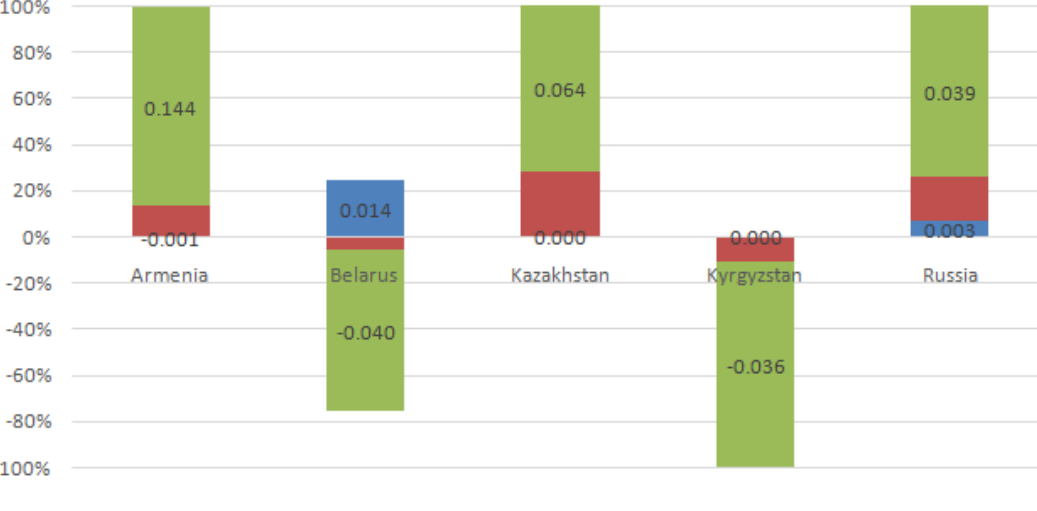
Graph 2: Possible Change in Production Volumes in the EEU Member States, % (Source: Own compilation)